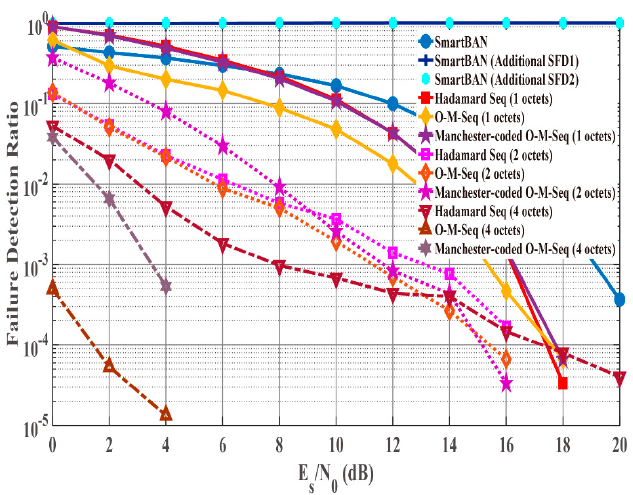
Figure 8. Failure detection ratio under the AWGN channel as function of E s / N 0 .